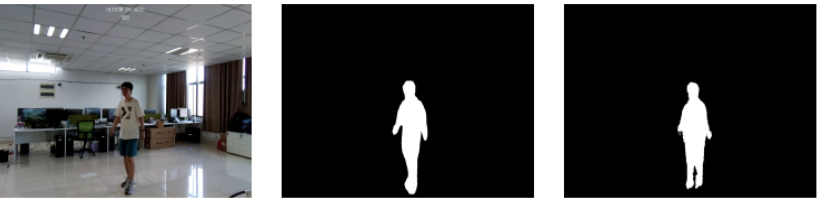
Figure 3. The human profile was generated by FMCW [64]. The images from left to right are the video frames, the ground truth, and the RFMask predicted human silhouette.